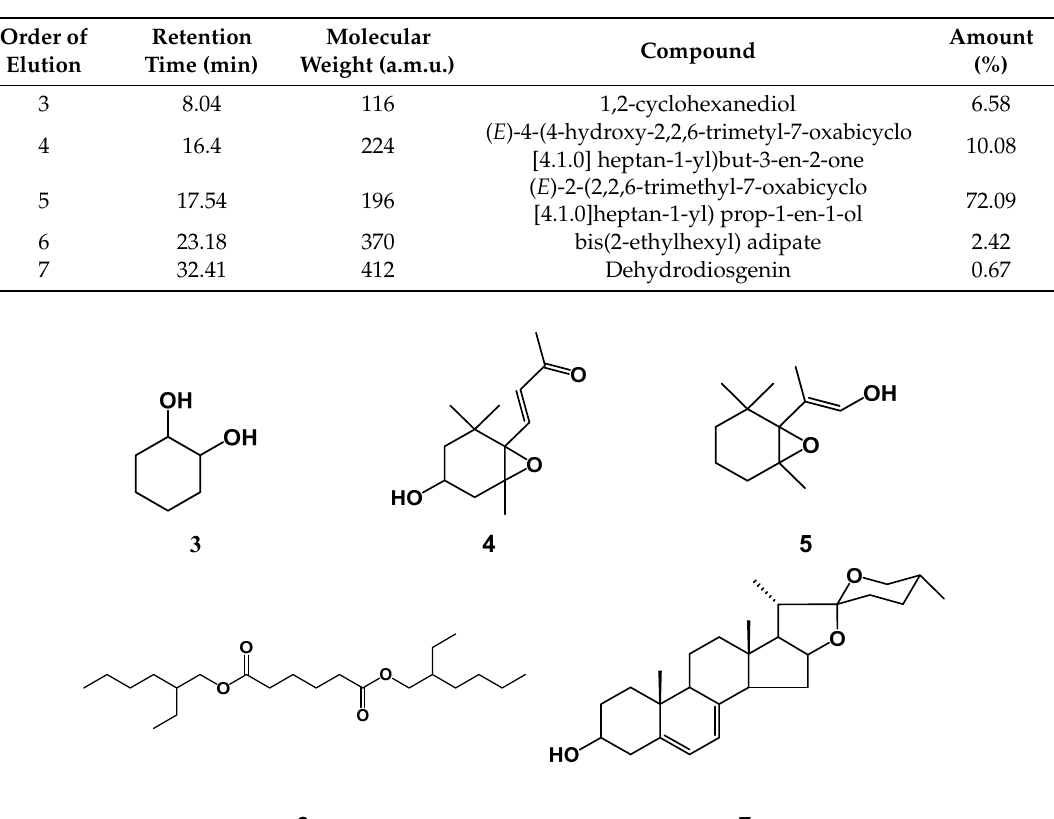
Figure 4. Chemical structure of compounds ( 3 – 7 ), identified preliminary by GC-MS from F7AC fraction.